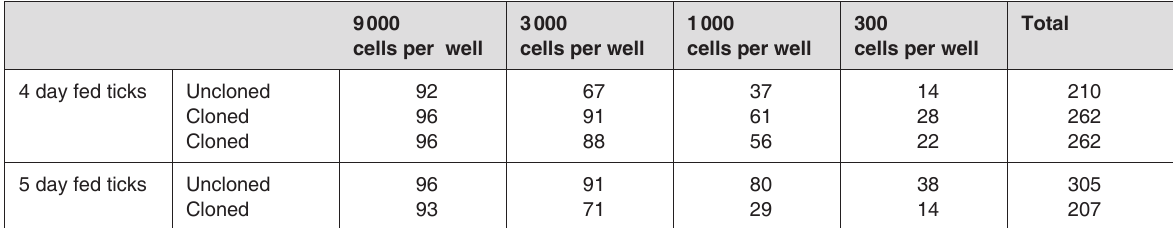
TABLE 2 In vitro assessment of infectivity of sporozoites of T. parva Marikebuni uncloned and clone 13. Data are mean numbers of wells with growth out of a total of 96 available wells for each concentration of cells per